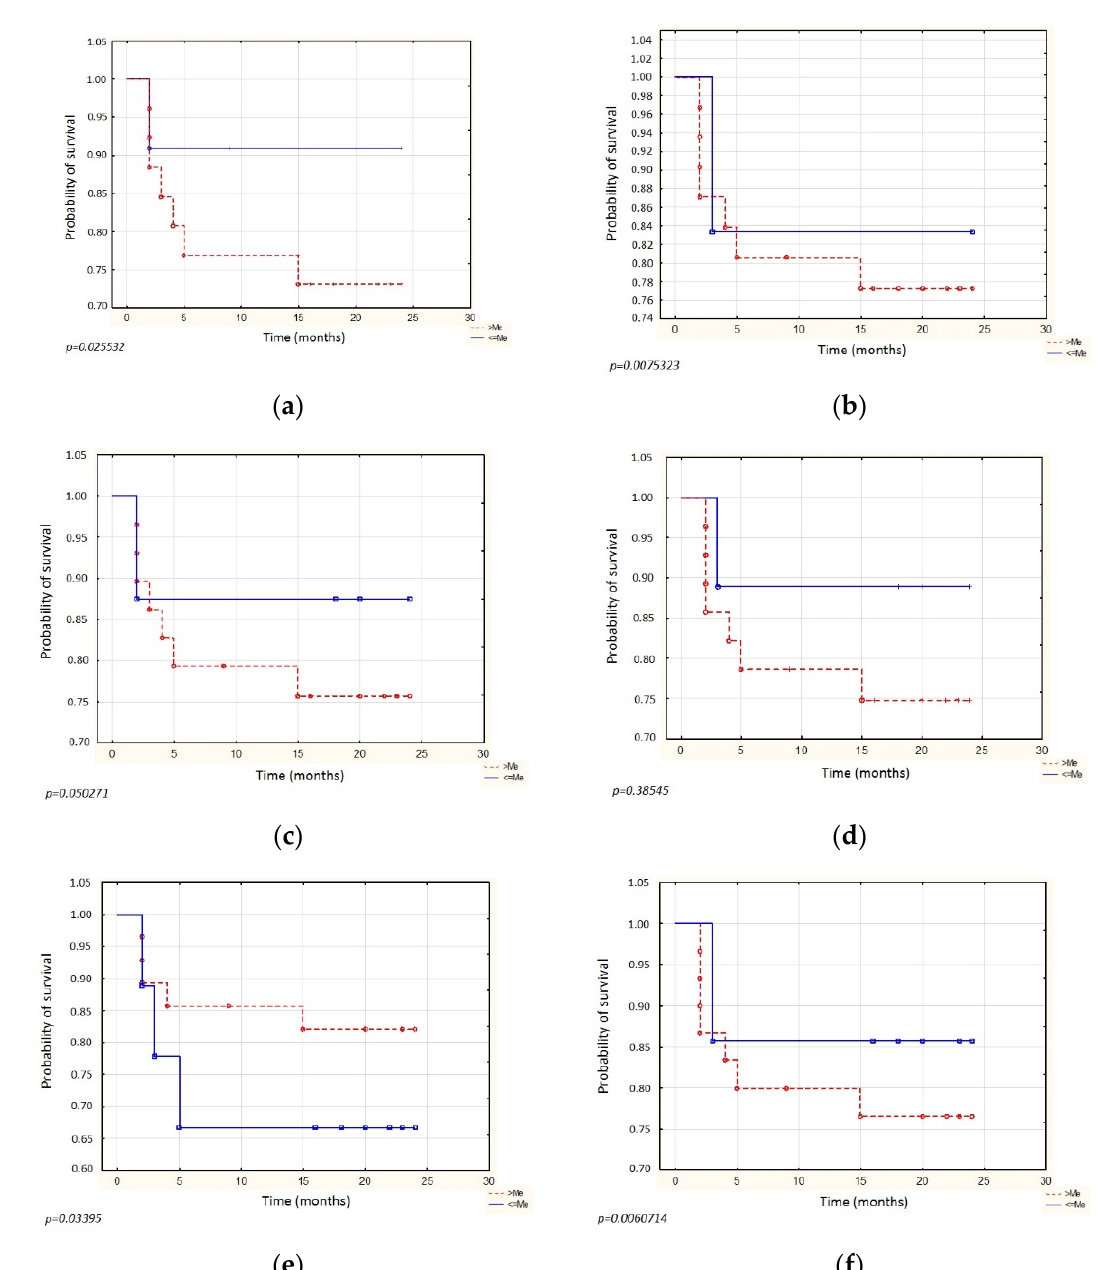
Figure 2. Kaplan–Meier curve representing overall survival for the following concentrations: ( a ) PD- L1 in serum, ( b ) PD-L1 in peritoneal fluid, ( c ) PD-1 in serum, ( d ) PD-1 in peritoneal fluid, ( e ) CTLA-4 in serum, ( f ) CTLA-4 in peritoneal